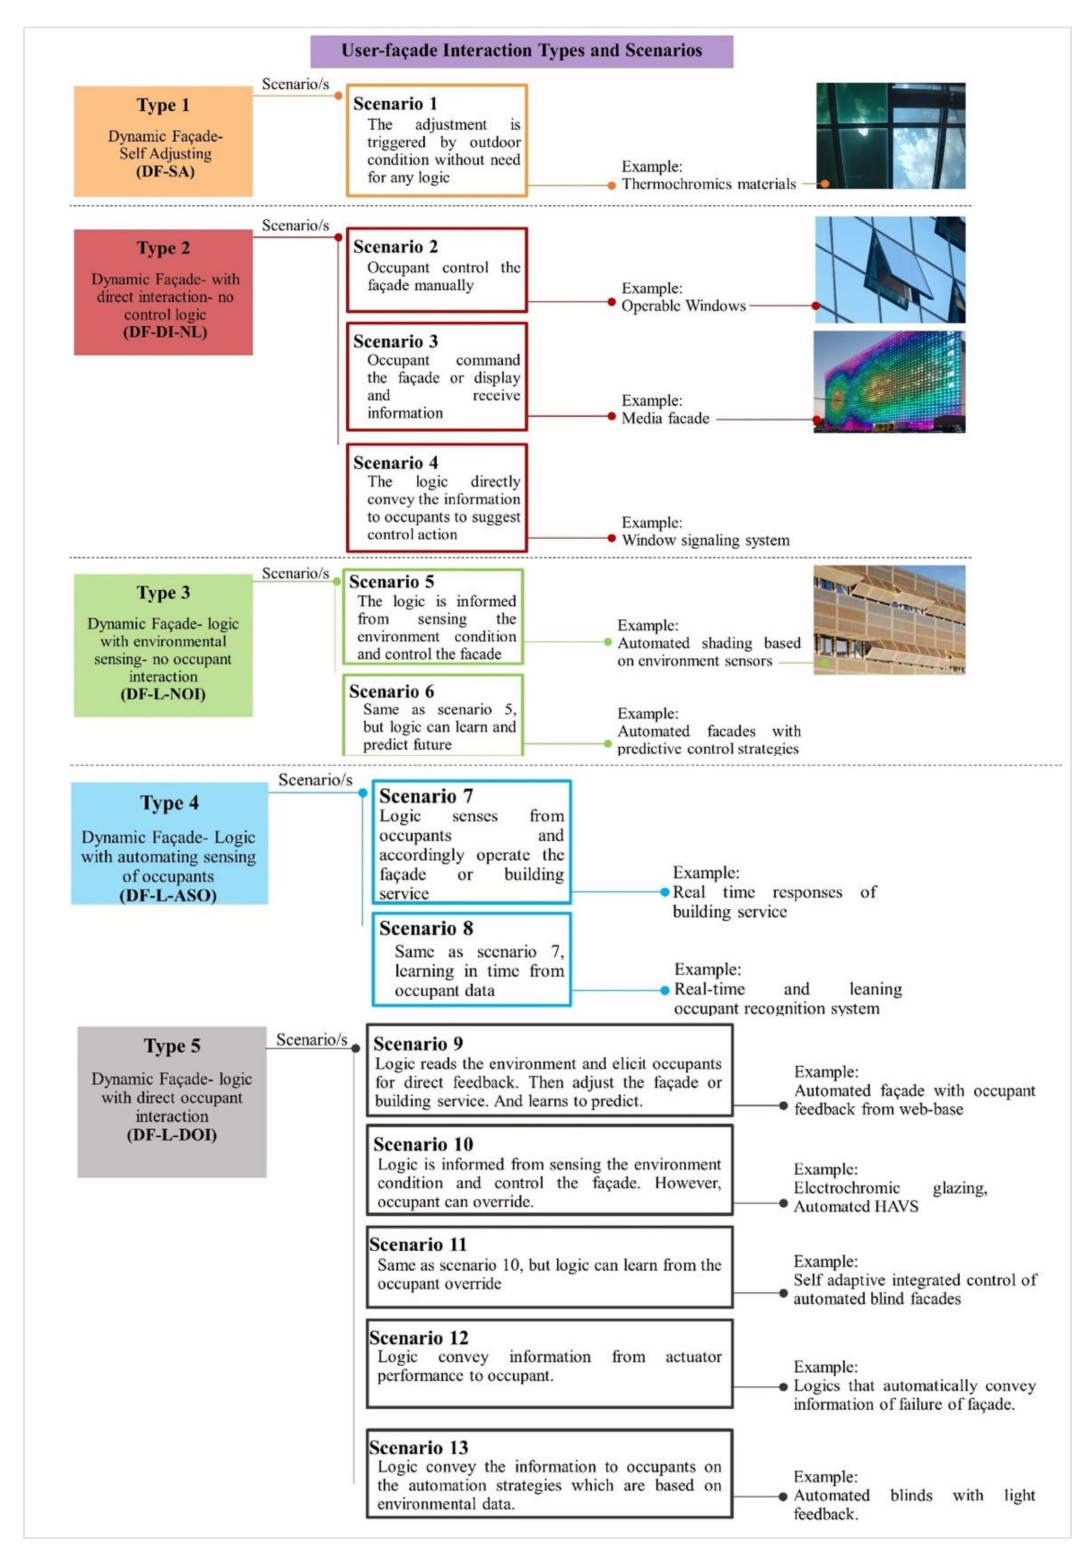
Figure 4. User–façade interaction types and scenarios [29], amended by the authors,